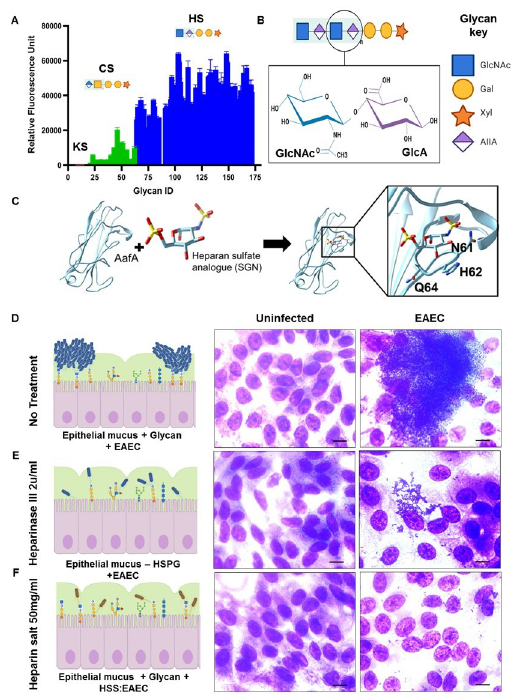
Fig 6. HSPG mediates adherence of EAEC to HIEMs. (A) GAG microarray of AafA shows high affinity binding to heparan sulfate GAGs. (B) shows the core chemical structure of HSPG. (C) Docking of SGN molecule on AafA reveals electrostatic interactions mediated by the residues H62, N61 and Q64. (D-F) Removal of HSPG by pretreatment of HIEs with heparinase III or addition of Heparan Sodium Salt (HSS) to EAEC as a competitive inhibitor exhibited reduced EAEC adherence on HIEs. Representative images, scale bars indicate 10 μ